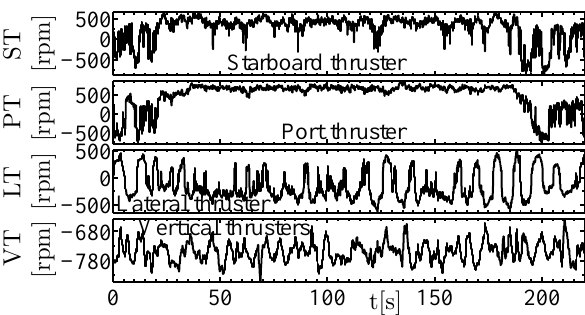
Figure 8: Commanded propeller